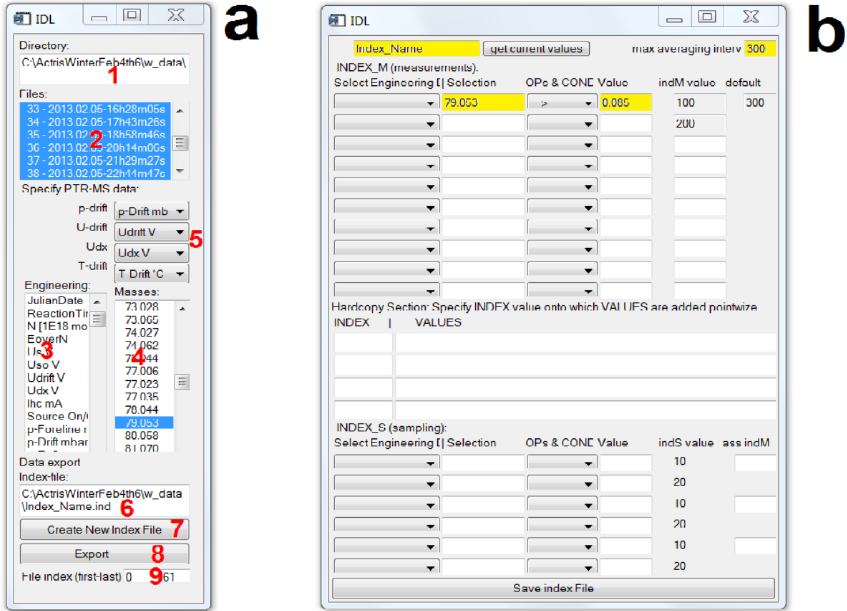
Figure B2. The “Average and Merge Data” tool widget windows. The main window (a) allows selecting and displaying data (example in Figs. 6 and 7) in order to produce and test useful data categorizations (Figs. 6b and 7) by creating an index file. The interactive elements are labeled with bold red numbers and briefly described in Appendix B. The “New Index File” widget window (b) allows creating complex data categories by using up to 10 conditions. Up to four index values can be manipulated in the hardcopy section, and up to three sampling indices can be created for in situ PTR-TOF-MS